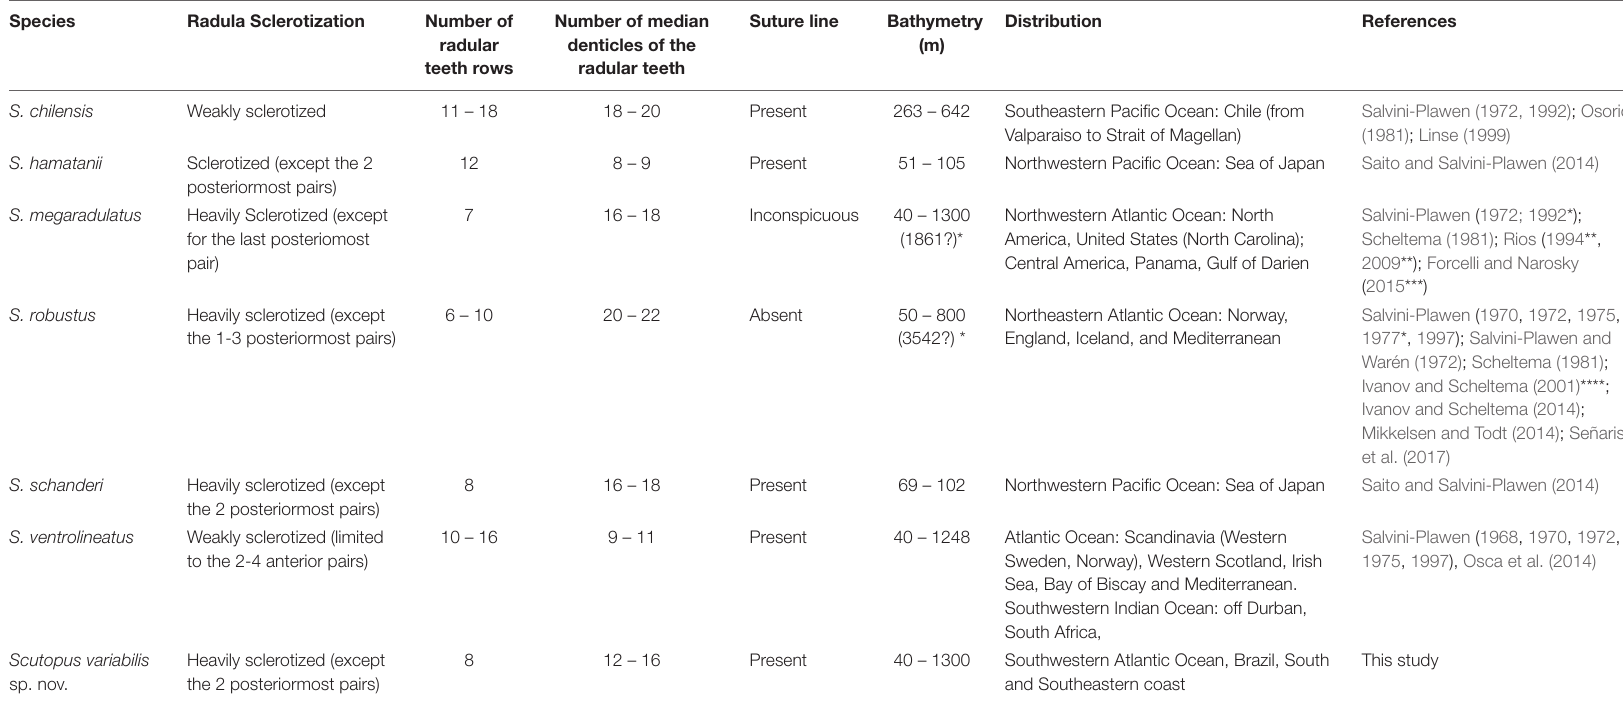
TABLE 3 | Summary data of main diagnostics characters, geographical and bathymetric distribution data of all Scutopus species described.